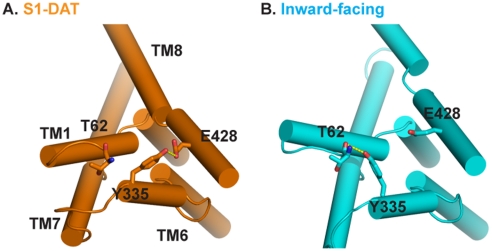
Changes in intracellular interaction networks.Y3356.68 forms an H-bond with E4288.66 in S1-DAT (A), and switches its H-bond partner to T621.27(NT) in the inward-facing conformation (B).